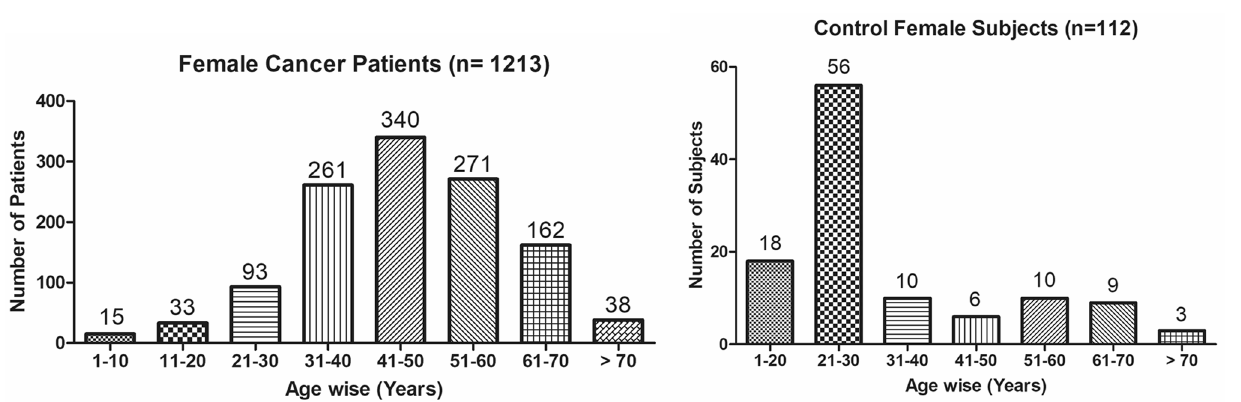
Figure 2. Graph showing age wise distribution of female cancer patients and control female subjects. (ANOVA- Dunnett’s Test, P <